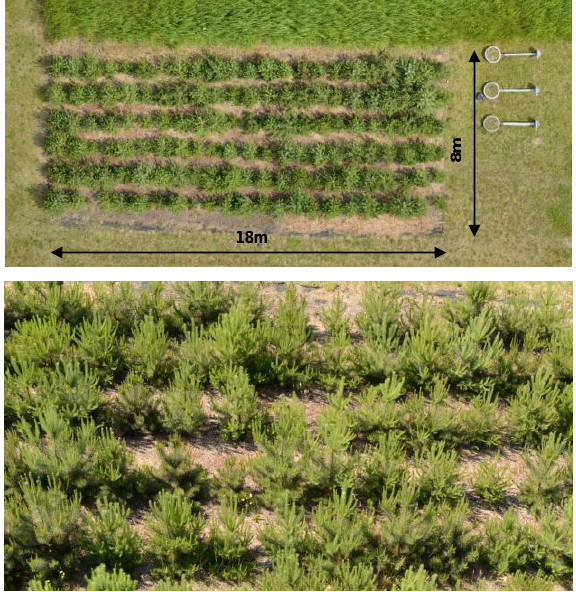
Figure 1. Ortophoto of study area (top); photo of measured plants (bottom)